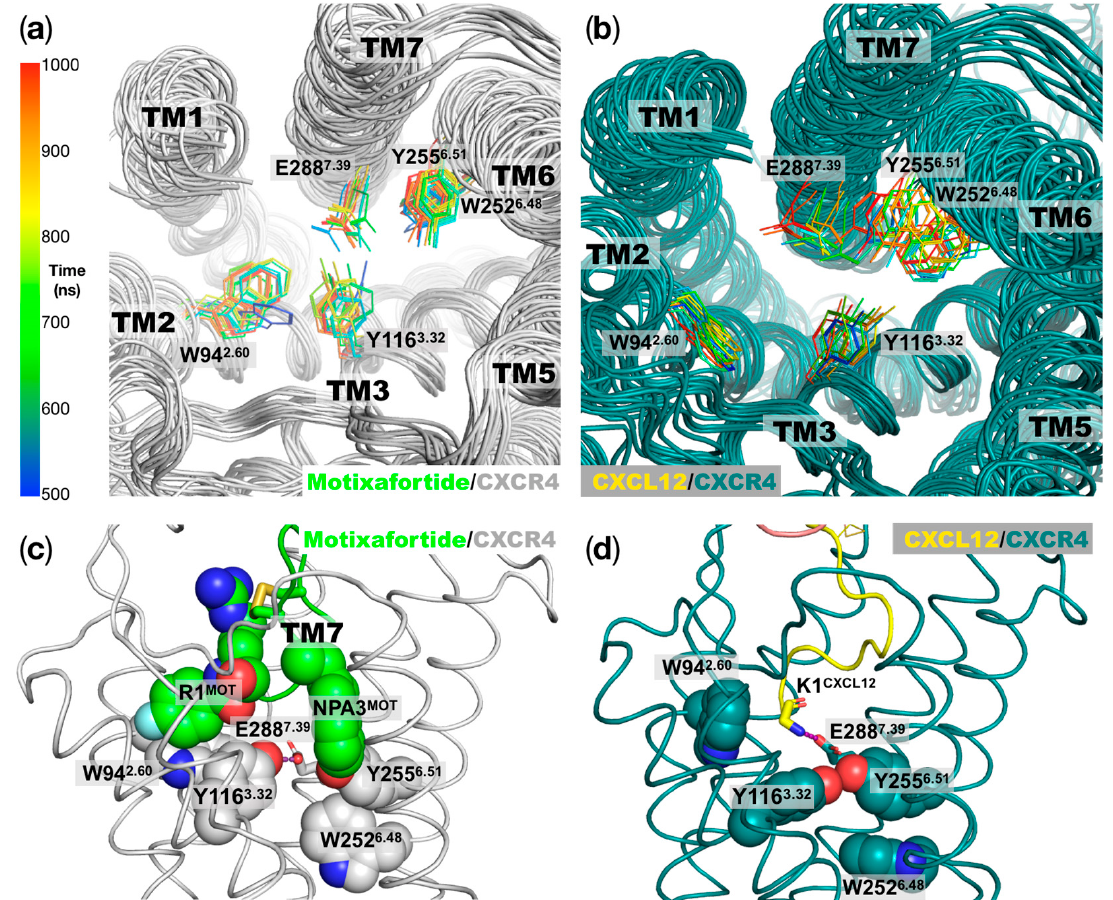
Figure 6 . Conformations of bulky residues at the orthosteric binding site linked to CXCR4 activation: ( a ) Motixafortide/CXCR4 superimposed conformations of residues important for ligand binding and activation at the CXCR4 orthosteric ligand binding site. The structures were taken every 50 ns for the last 500 ns of the trajectory (500 to 1000 ns) and are depicted according to the gradient color code on the right panel. ( b ) Similar representation as in panel ( a ), but for the CXCL12/CXCR4 system. In panels ( a , b ) we can observe more dynamic behavior in the agonist-bound system relative to the antagonist-bound CXCR4 receptor for particular residues that have been implicated in ligand binding and CXCR4 activation. ( c ) Representative structure of the motixafortide/CXCR4 complex, where the two synthetic chemical moieties at positions 1 and 3 and the CXCR4 residues in their close proximity are depicted as spheres. The polar interaction of residue Y116 3.32 with E288 7.39 is highlighted using a purple dashed line. ( d ) Similar orientation as in panel ( c ), but for the CXCL12/CXCR4 protein complex. Here, the polar interaction of residue Y116 3.32 -E288 7.39 is replaced by the Y116 3.32 -Y255 6.51 polar interaction (purple dashed line). In this case, the positively charged moiety in the K1 CXCL12 backbone establishes a charge–charge interaction with E288 7.39 .